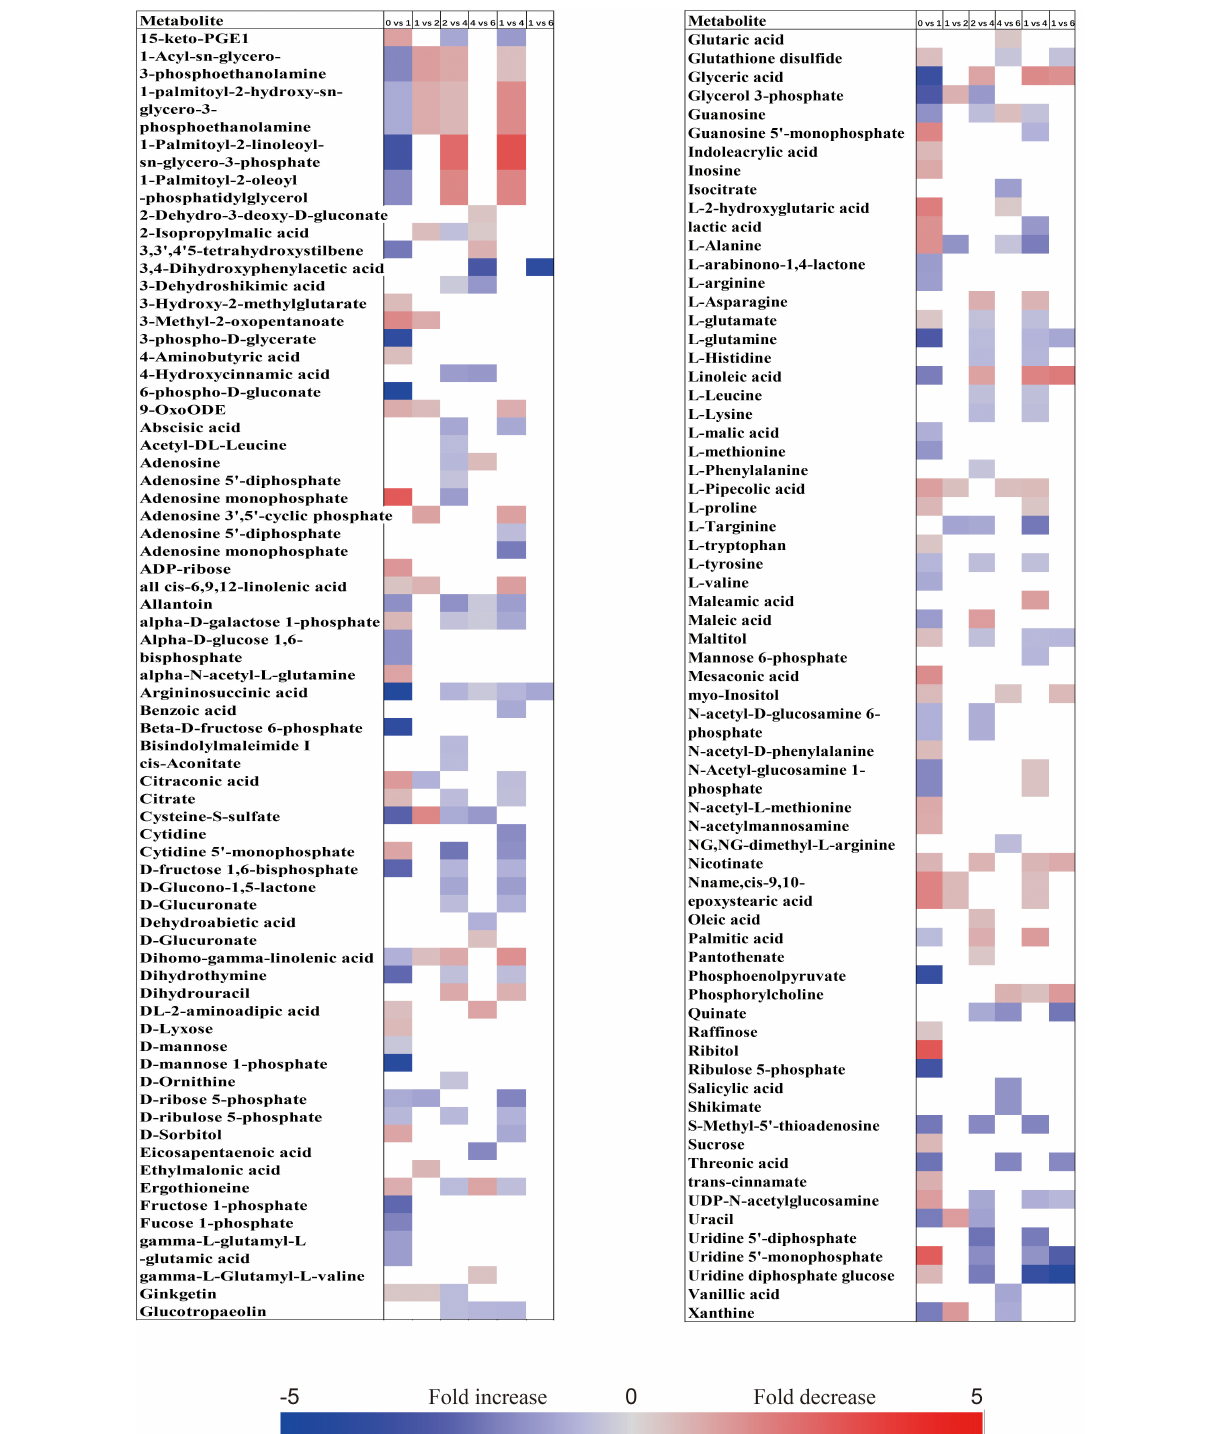
Frontiers in Plant Science |